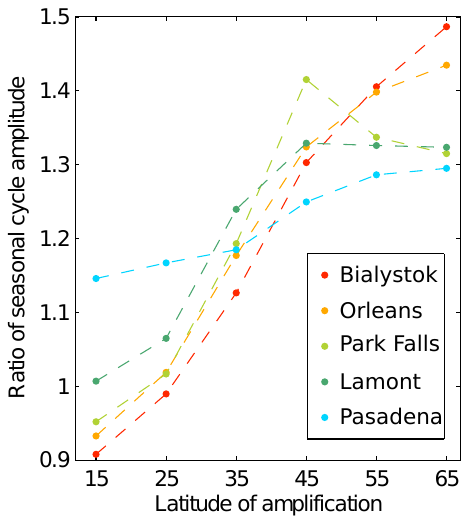
Fig. 9. Amplification in h CO 2 i bio seasonal cycle amplitude when NEE is enhanced in 10 ◦ latitude bands relative to CASA NEE. The seasonal cycle amplitude from simulations with enhanced NEE is normalized by the corresponding seasonal cycle amplitude result- ing from CASA fluxes. The seasonal cycle amplitude is more sen- sitive to flux enhancements in boreal ecosystems, due to the greater seasonality of